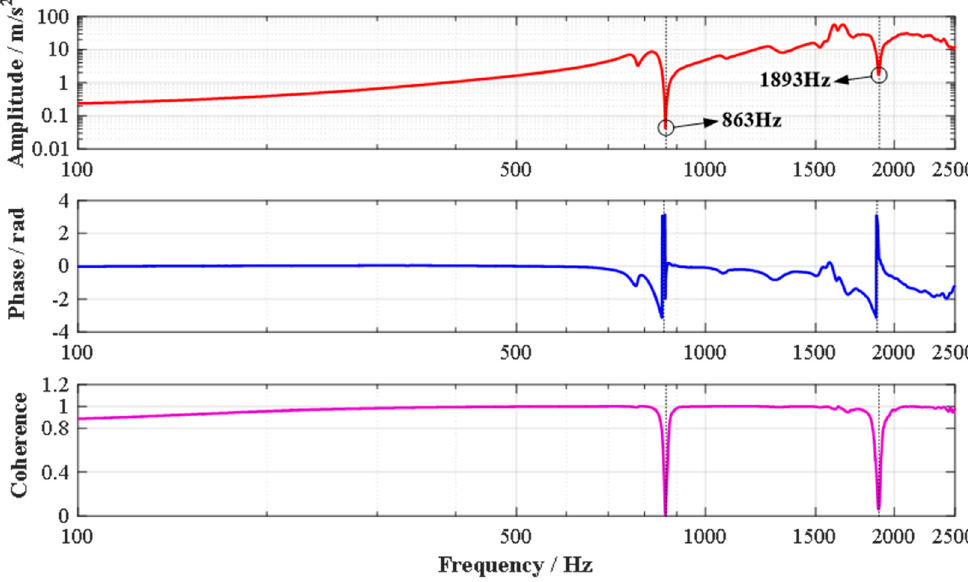
Figure 13. The experimental results of the dynamic performances of the 2-DOF PDCM system. ( a ) Amplitude-frequency; ( b ) Phase-frequency; ( c ) Coherence-frequency .